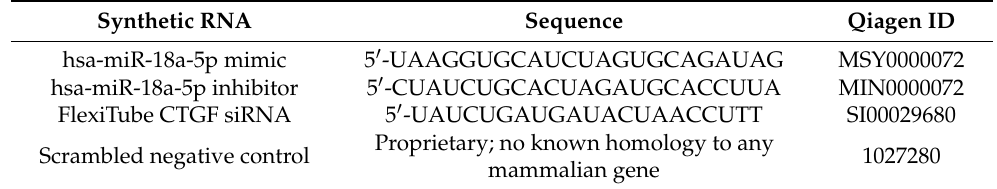
Table 1. Sequences of miScript miR-18a mimic and inhibitor, CTGF siRNA and scrambled negative control. Synthetic RNA Sequence Qiagen ID hsa-miR-18a-5p mimic 5 (cid:48) -UAAGGUGCAUCUAGUGCAGAUAG MSY0000072 hsa-miR-18a-5p inhibitor 5 (cid:48) -CUAUCUGCACUAGAUGCACCUUA MIN0000072 FlexiTube CTGF siRNA 5 (cid:48) -UAUCUGAUGAUACUAACCUTT SI00029680 Proprietary; no known homology to any Scrambled negative control mammalian gene